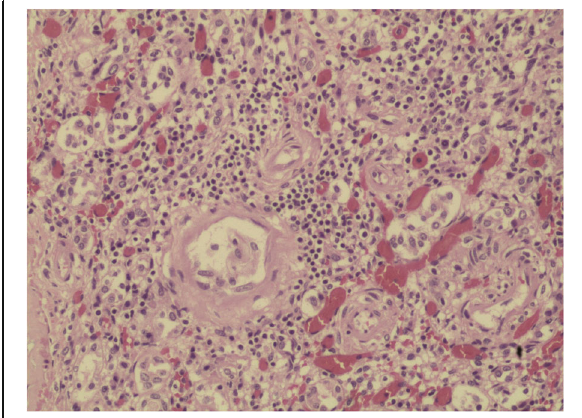
Fig. 3 Section of the kidney showed presence of sclerosed glomerulus with inflammatory infiltration predominantly lymphocytes and histiocytes (asterisk). There was also evidence of interstitial fibrosis and atrophic tubules. (H&E